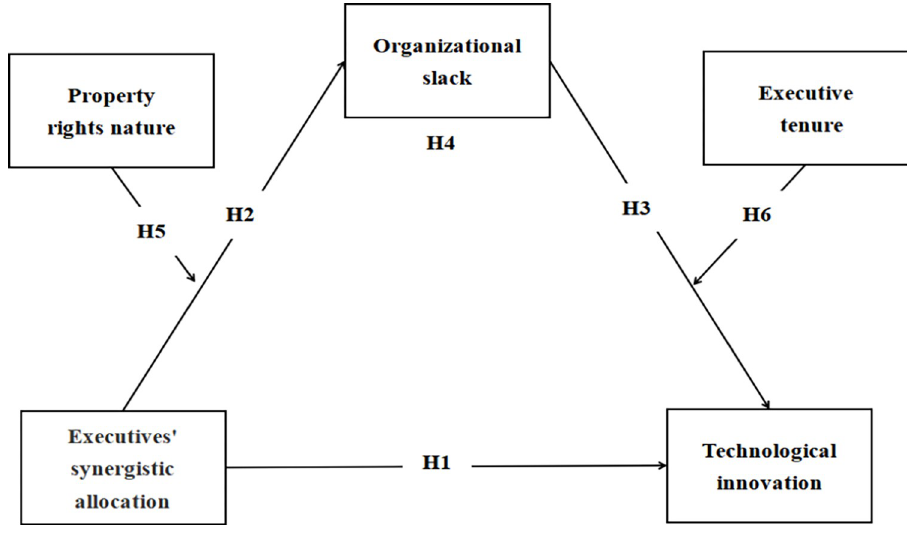
Fig 2. Hypothetical